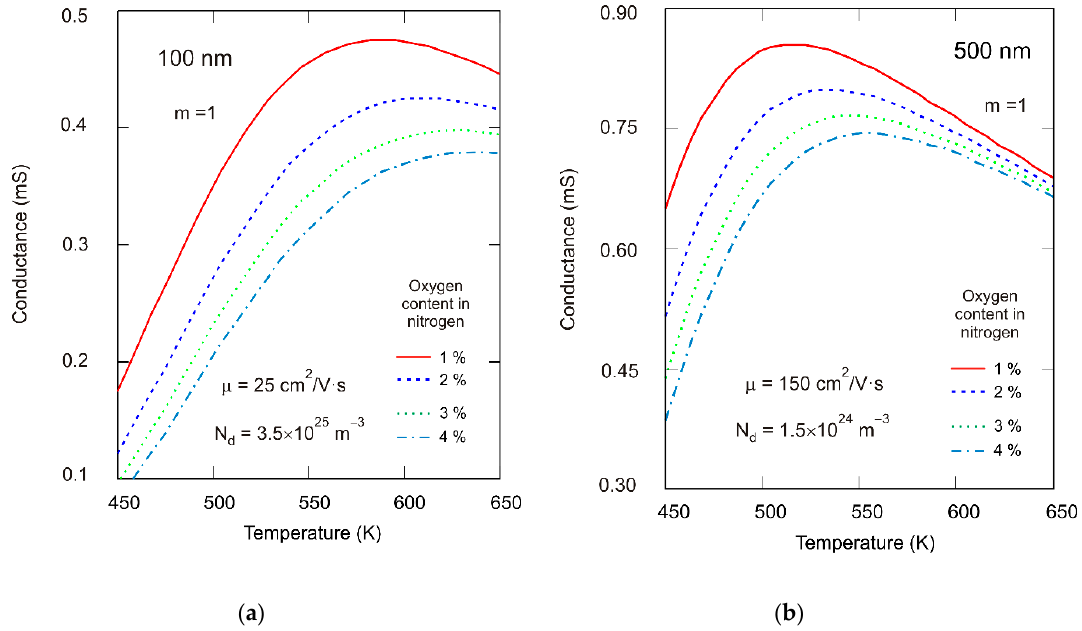
Figure 13. Calculated conductance versus temperature of the SnO 2 thin film sensor for different oxygen content in nitrogen for sample thickness of ( a ) 100 nm and ( b ) 500 nm for single donors m = 1 (N d —donor concentration in bulk; µ—mobility of electrons—which were assumed).